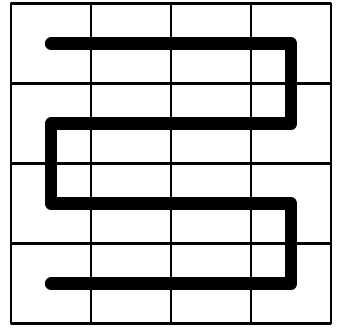
Figure 10. This example illustrates the connections between the tiles in a solution for the multi-row case for a Chimera graph of size 4 × 4 cells, each cell representing a tile with one problem variable, with the exception of first and last tiles that contain no problem